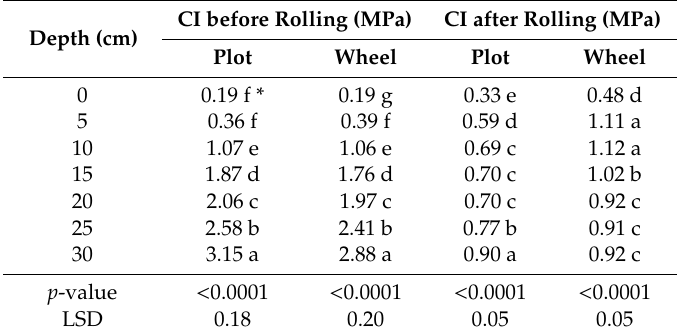
Table 12. Soil cone index (CI) values for di ff erent depths (0–30 cm, with 5 cm increments) averaged over rolling treatments in 2015 growing